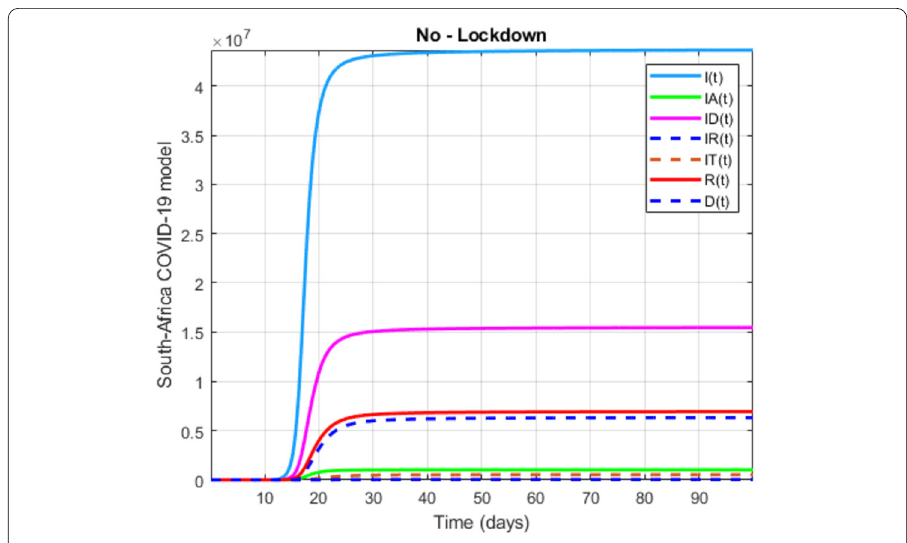
Figure 41 Numerical visualization for Covid-19 model in South Africa for α = 0.9, β =